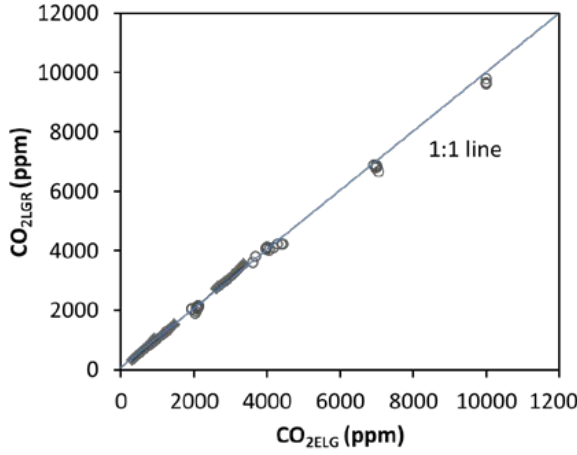
Figure 1. Map indicating the locations of the chambers on lake Tämnaren. The map is published with permission from Lantmä- teriet, Sweden, according to agreement i2012/898 with Linköping University.